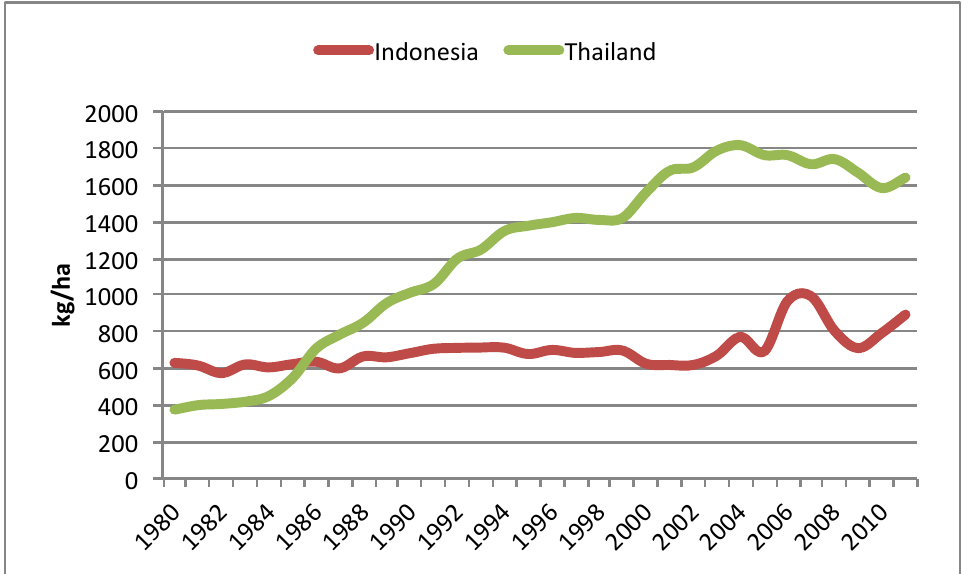
Figure 1. Yields of rubber in intensified systems of Thailand and more extensive systems of Indonesia. Source: